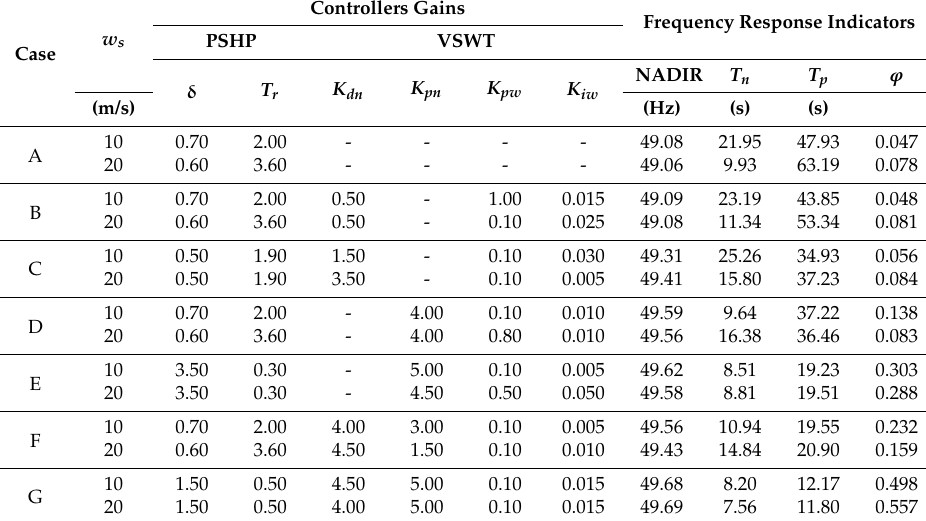
Table 4. Exhaustive search results.